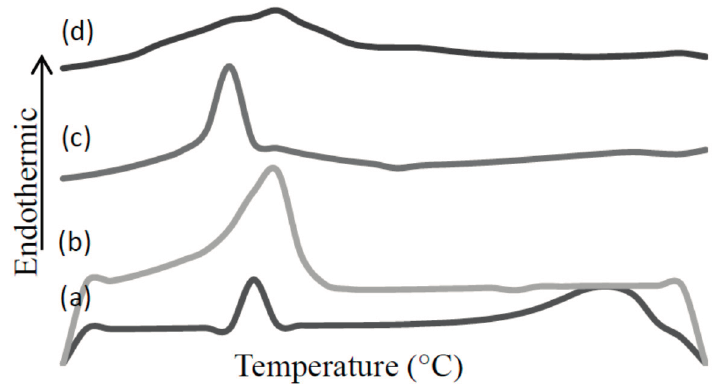
Figure 12. Differential Scanning Calorimeter (DSC) curves of (a) BzP; (b) MAA- β -CD; (c) MAA- β -CD-BzP physical mixture; (d) MAA- β -CD-BzP